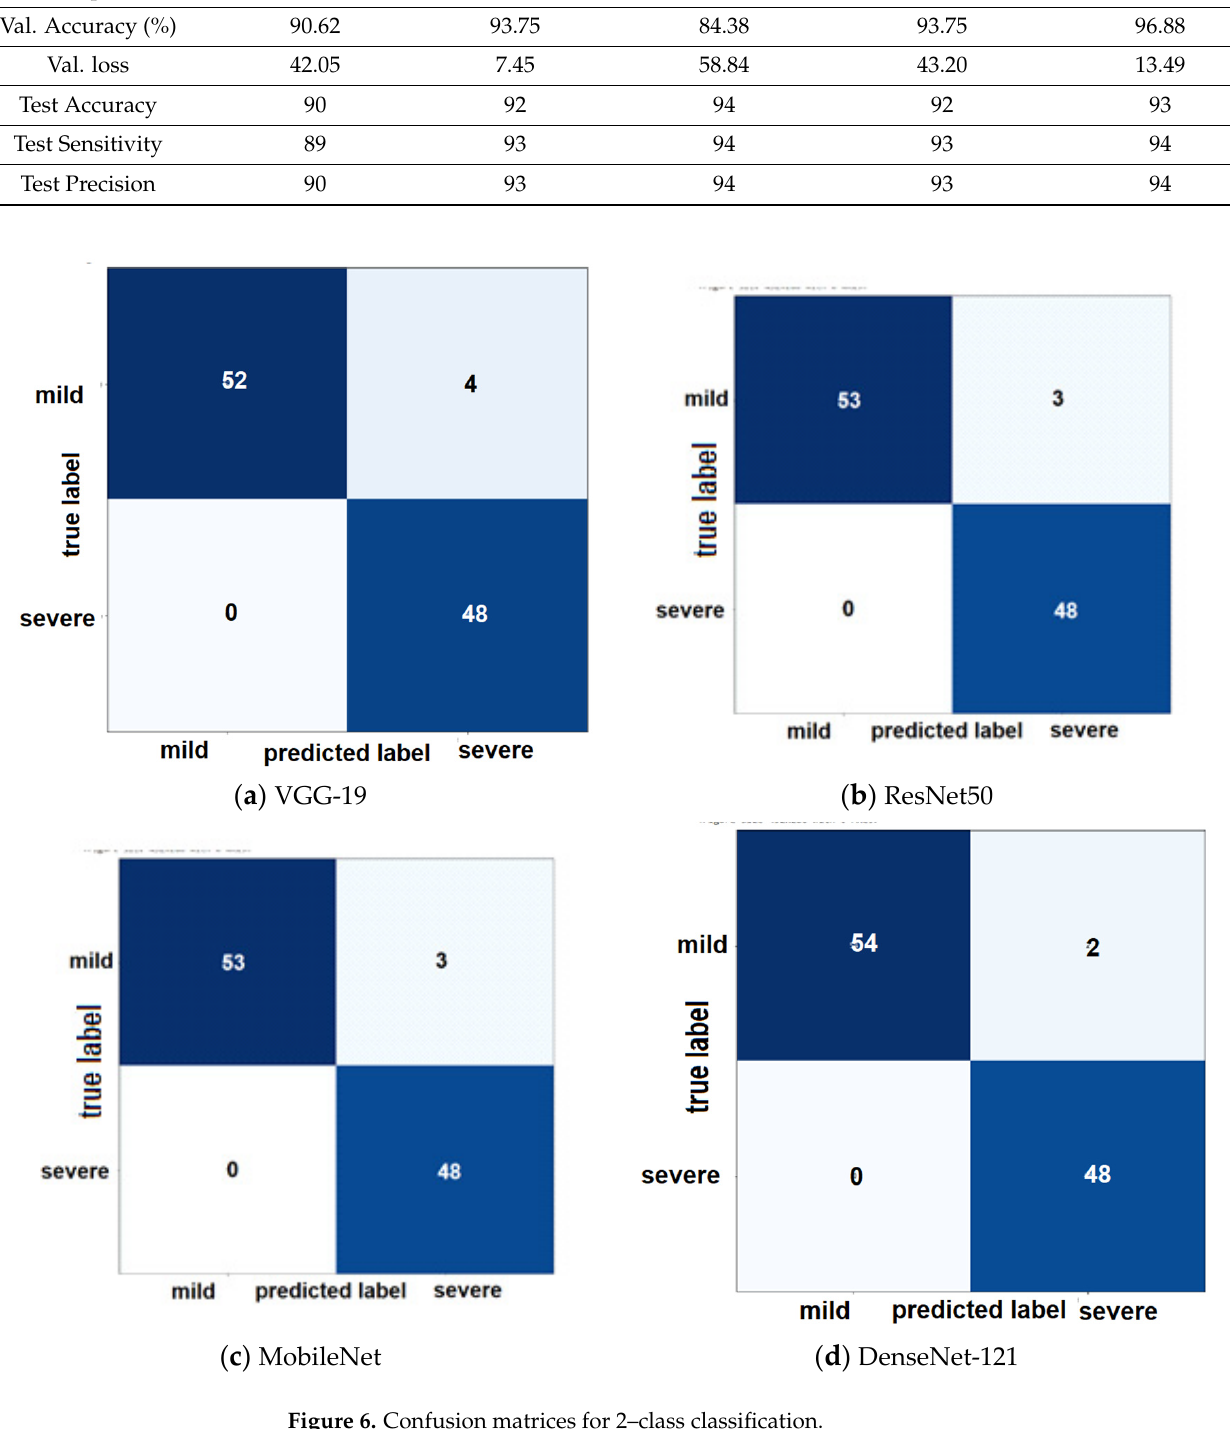
Figure 6. Confusion matrices for 2–class classification. Table 4. Comparison of pre-trained models for 4 Class Classification.